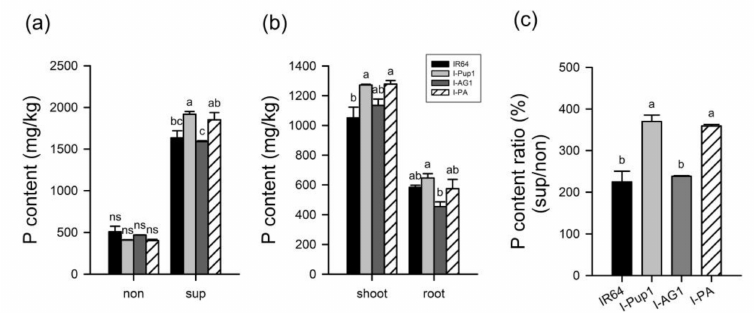
Figure 3. Total P content of I-PA and NILs under P-non and P-sup conditions at 48 days after transplanting (DAT). ( a ) Total P content under P non-supplied and P-supplied conditions at 48 DAT. non: P non-supplied condition; sup: P-supplied condition. ( b ) Total P content of shoots and roots under P-supplied condition. ( c ) Increase in total P content under P-supplied condition versus P non-supplied condition. The letters above bars represent statistical significance ( p < 0.01) as measured by Duncan’s multiple range test. ns: no significant di ff